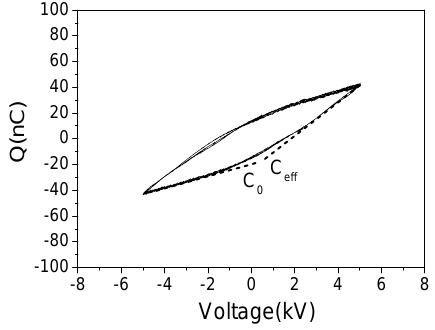
Figure 3. Lissajous figure of the un ‐ fluorinated device ( V pp = 10 kV, f = 6 kHz).